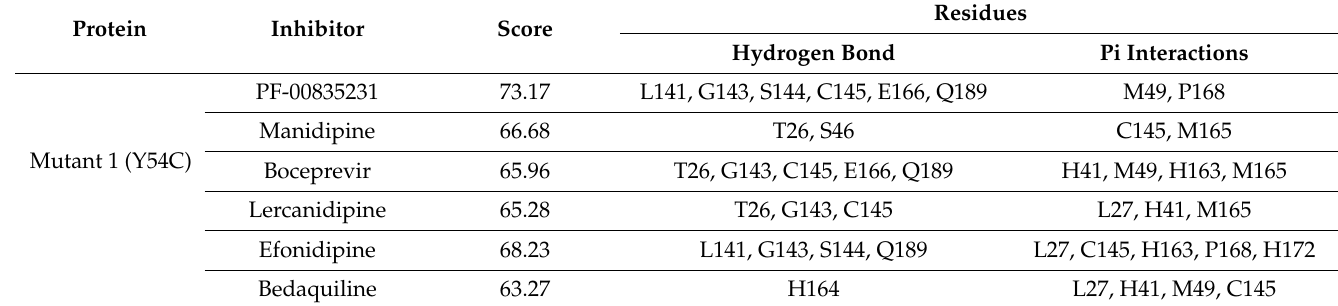
Table 2. The binding details of all compounds against the Mutant 1 (Y54C) Mpro.